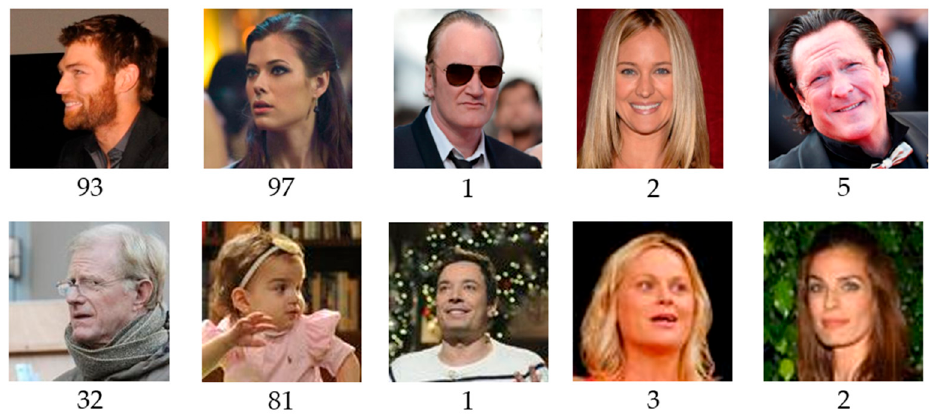
Figure 3. Example of wrongly age annotated image samples in the existing IMDB-WIKI benchmark dataset.